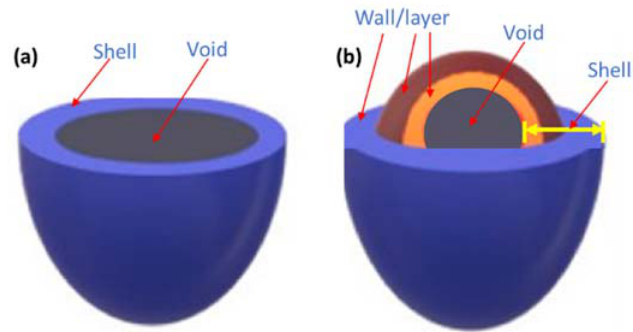
Figure 5. Types of hollow spherical particles: ( a ) single-shelled structure and ( b ) multi-shelled structure (reproduced from Ref. [36] with permission from the